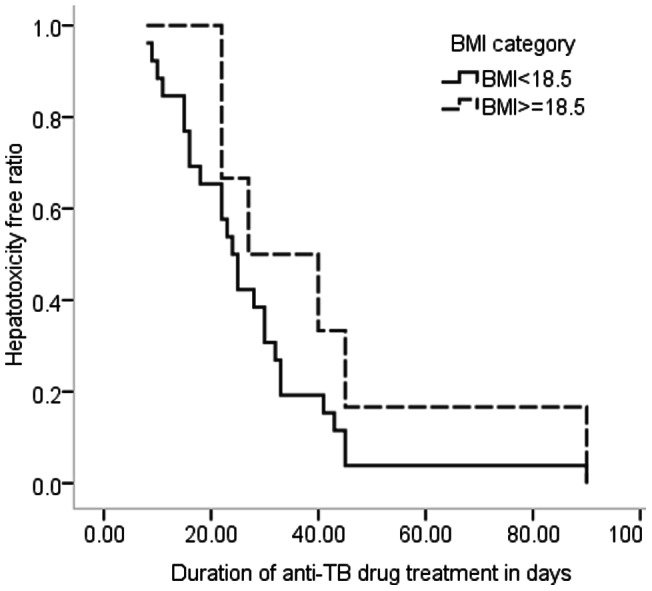
Duration of patients stay on anti-TB drugs before the occurrence of hepatotoxicity by BMI.